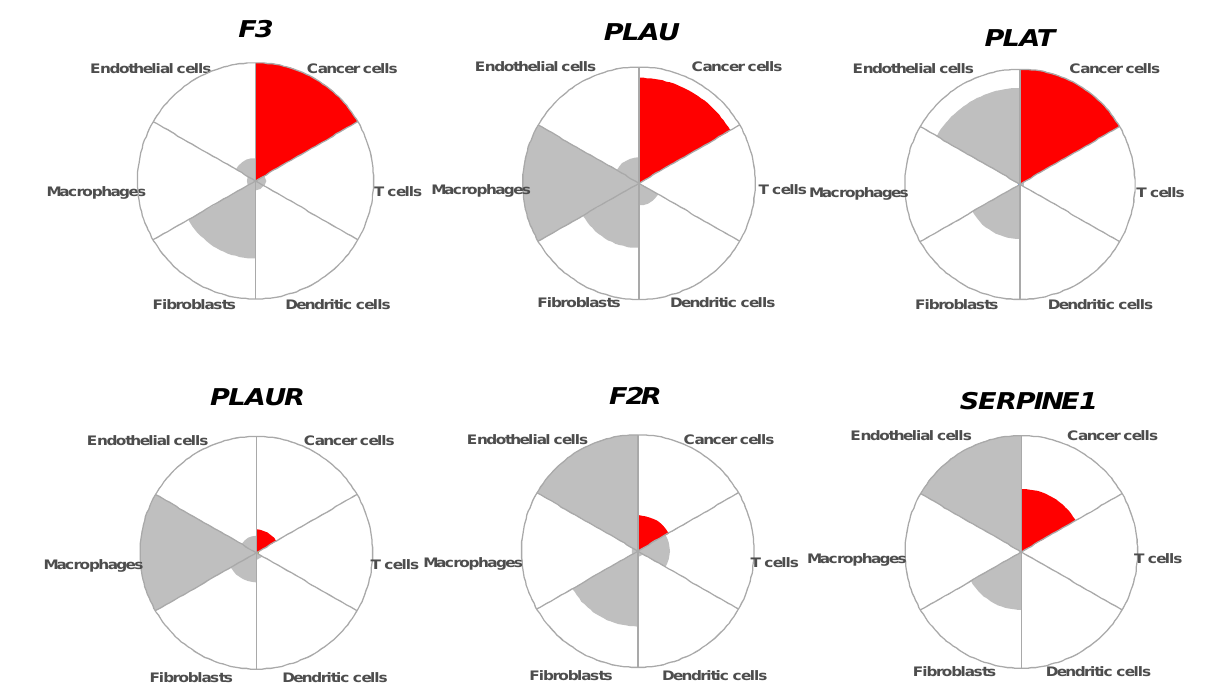
Figure 5. Polar plots showing the mRNA expression of the core coagulome genes ( F3 , PLAU , PLAT , PLAUR , F2R and SERPINE1 ) in different cell subpopulations of OSCC. The graphs show the relative expression of each gene in the different cell types (malignant cancer cells, T cells, dendritic cells, macrophages, endothelial cells and fibroblasts) using scRNA-seq data from GSE103322. In each case, the cell type with the highest expression (median) was set as maximum. Note that cancer cells are shown in